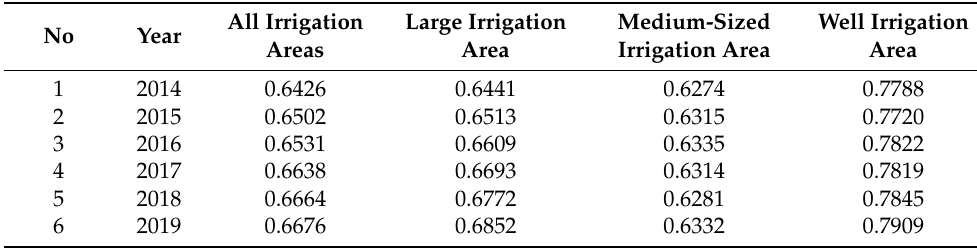
Table 3. Effective utilization coefficient of irrigation water for irrigation areas in the study area during 2014 – 2019.